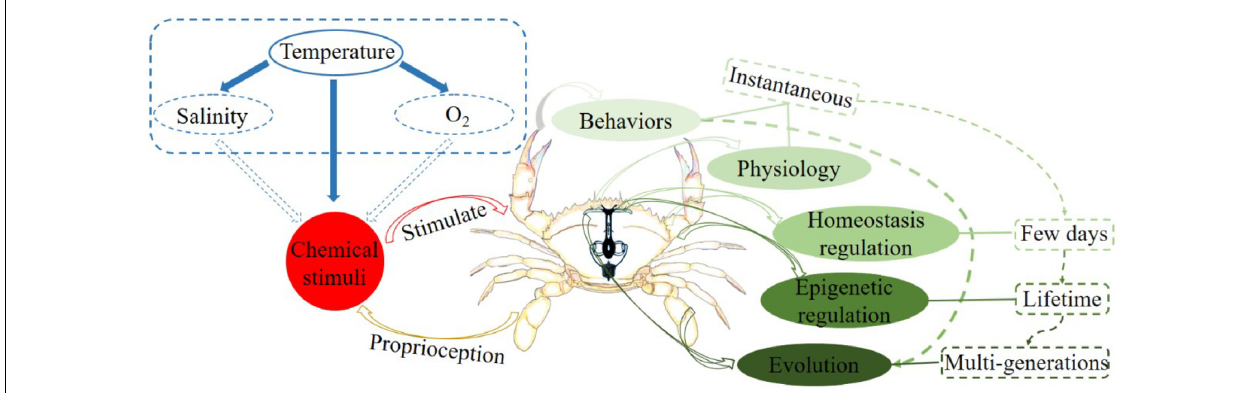
FIGURE 1 | Diagram of the interaction between temperature fluctuations and crustacean regulatory